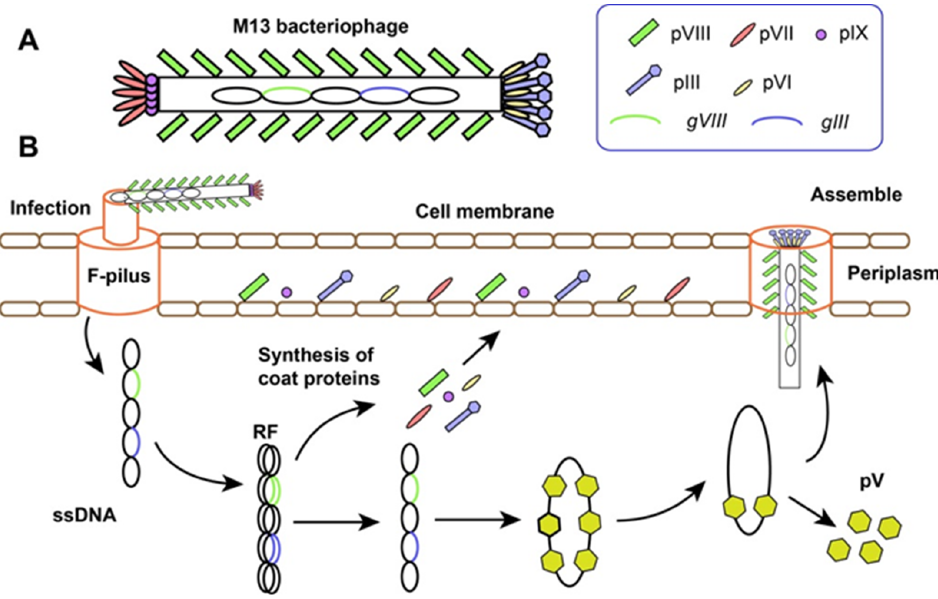
Figure 1. The basic structure ( A ) and life cycle ( B ) of filamentous bacteriophage.